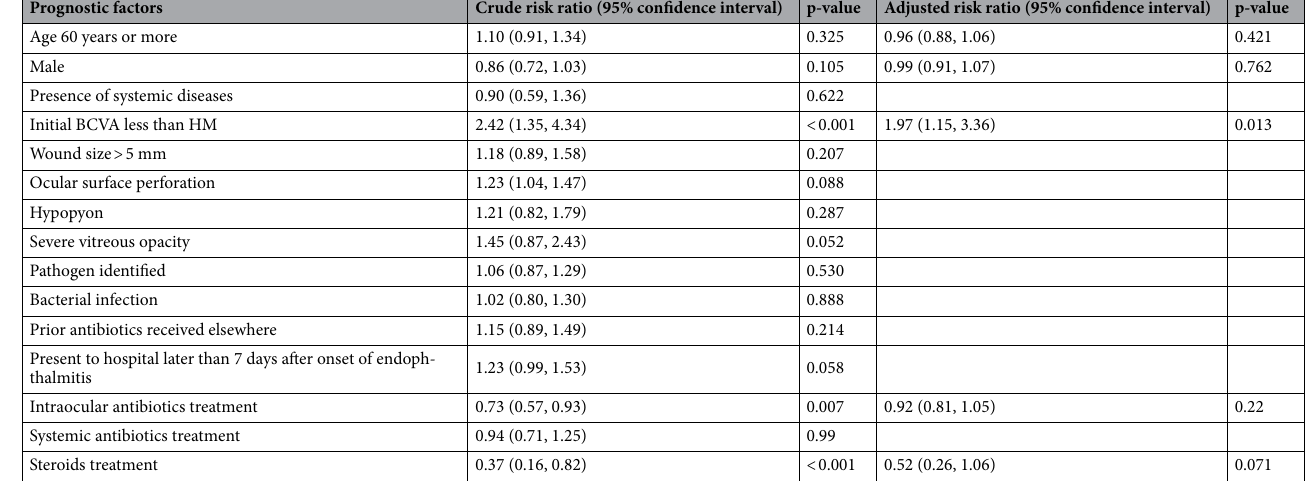
Table 4. Regression analyses indicated risk ratio of prognostic factors for poor final visual outcome (less than hand movement). BCVA best corrected visual acuity, HM hand